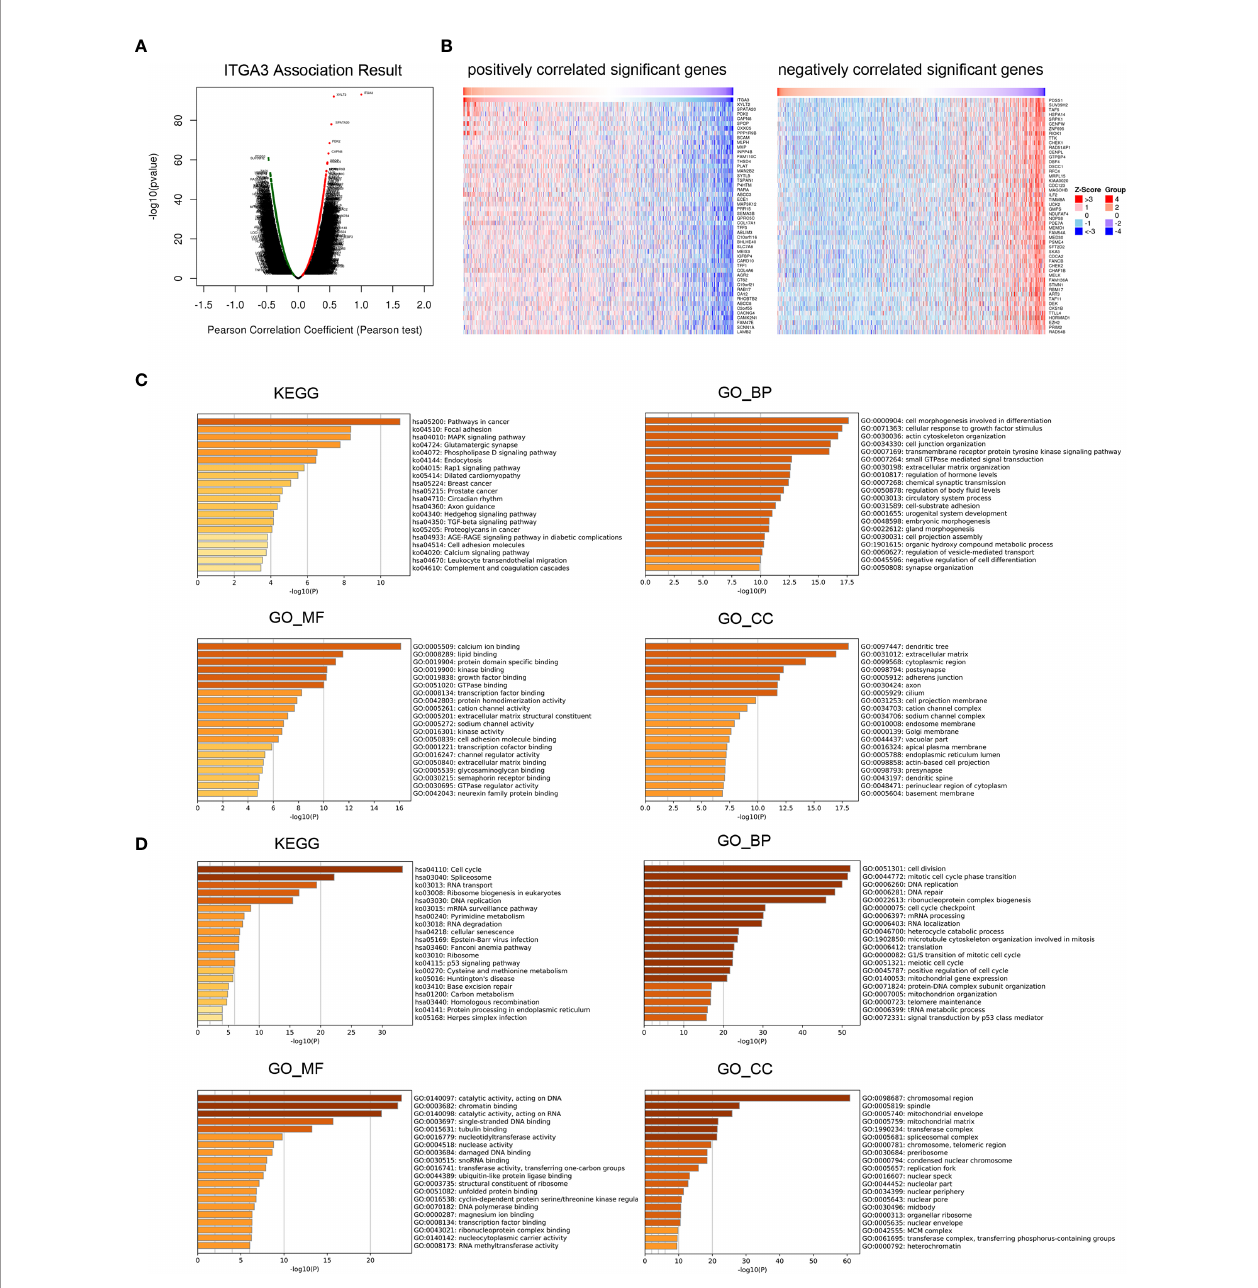
FIGURE 7 | ITGA3 co-expression genes and pathways enrichment in BRCA. (A) Volcano plot of ITGA3 association result. (B) Heat maps showing top 50 genes positively and negatively correlated with ITGA3 in BRCA. Red indicates positively correlated genes and blue indicates negatively correlated genes. (C) KEGG, GO_BP, GO_MF, GO_CC pathway enrichment of positively correlated genes with ITGA3 . (D) KEGG, GO_BP, GO_MF, GO_CC pathway enrichment of negatively correlated genes with ITGA3